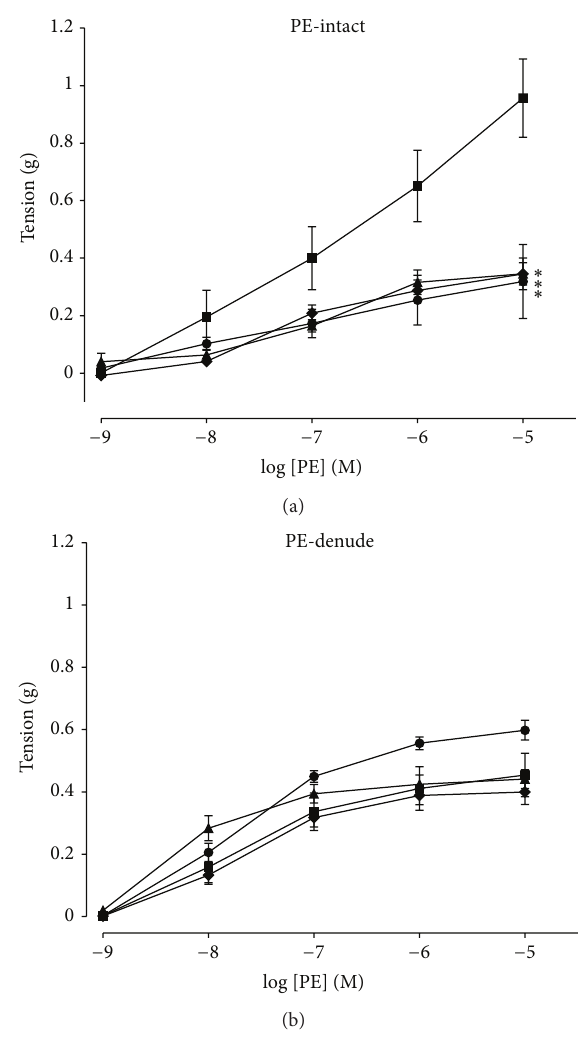
Figure 1: PE-induced contraction responses in intact (a) and denude (b) aortic rings from SHR treated with control ( ◼ ), losartan ( 󳵳 ), and WOS ( ∙ ) and WMOS ( Q ). Responses to PE are expressed as difference between absolute tension developed and baseline tension. Values are mean ± SEM of 5 to 8SHRs in each group. ∗ Denotes 𝑃 < 0.05 compared to control analyzed by one-way ANOVA followed by Dunnett post hoc test.